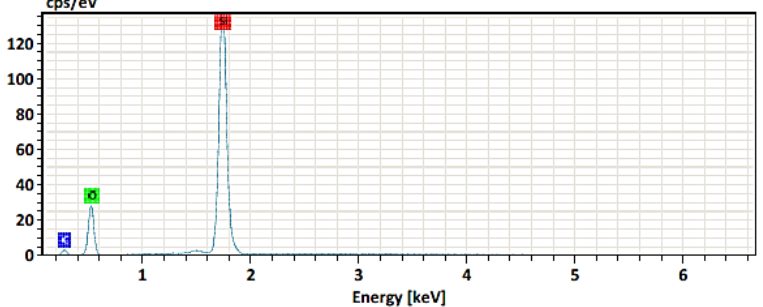
Table 3. Elemental analysis of the SiO 2 nanoparticles.